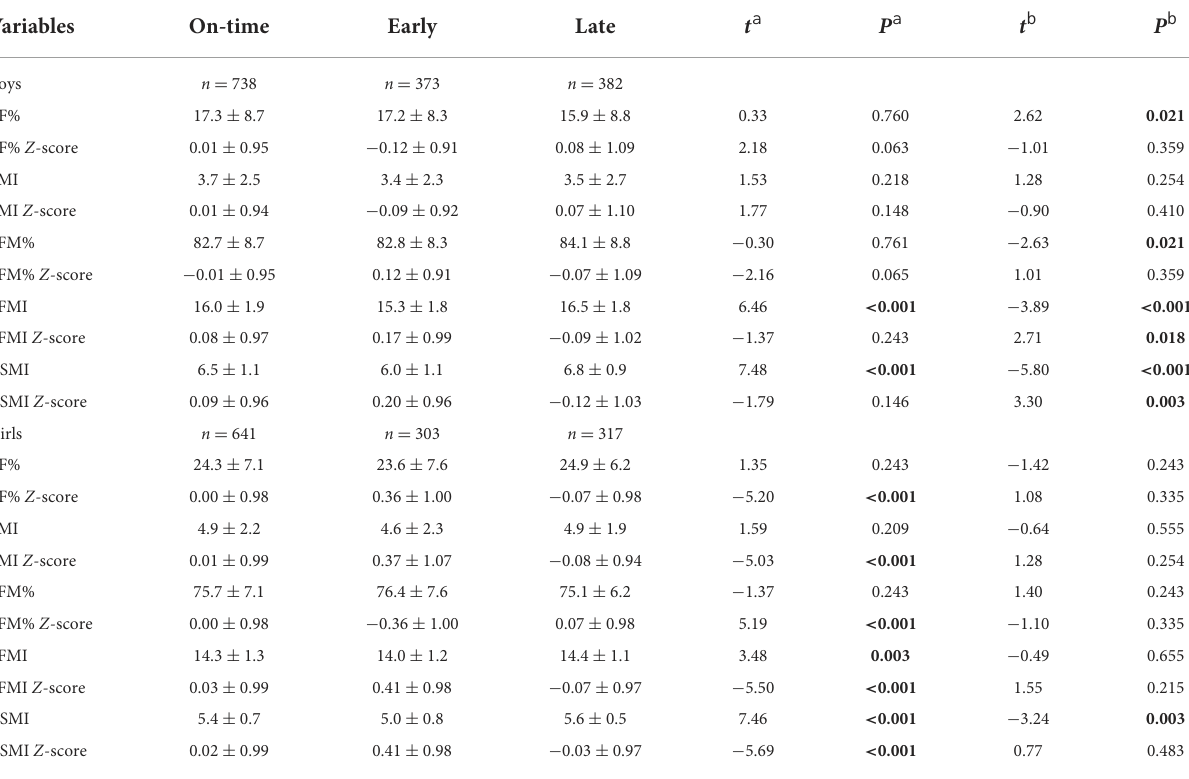
TABLE 2 Body composition characteristics in boys and girls with early, on-time, and late puberty.